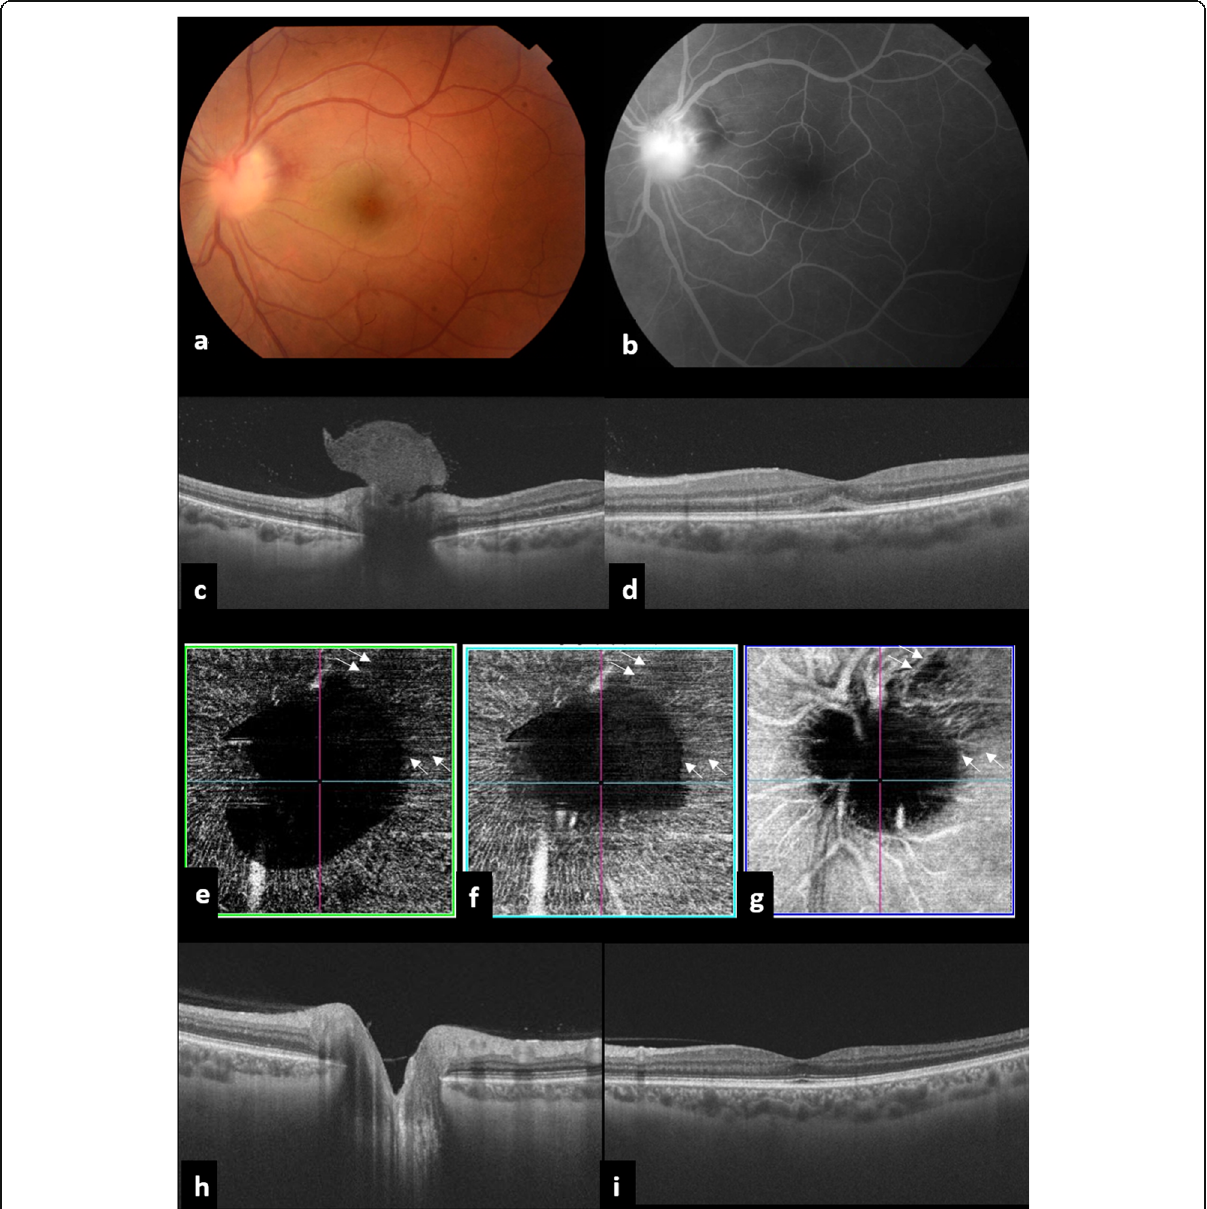
Fig. 1 Multimodal imaging of the left eye at first presentation. a Fundus photograph showing a localized inflammatory vitreous exudate overlying an infiltrated optic disc and peripapillary retina with associated retinal hemorrhages b Late-phase fluorescein angiography demonstrating optic disc leakage and masking effect from retinal hemorrhages. c SS OCT of the optic nerve head showing a “ mushroom-shaped ” hyperreflectivity of the prepapillary vitreous exudation seen on clinical examination. d Macular SS OCT showing an associated shallow macular serous retinal detachment. e , f , g SS OCTA revealing a dark area overlying the optic disc due to blockage from the prepapillary exudate. The prepapillary hypointense area decreases in size while scanning deeper layers, reflecting the “ mushroom-saphed ” pattern of the prepapillary vitreous exudate. Note the presence of a superotemporal hyposignal area (arrows). One month after presentation, SS OCT shows the resolution of the prepapillary vitreous exudate and serous retinal detachment ( h , i